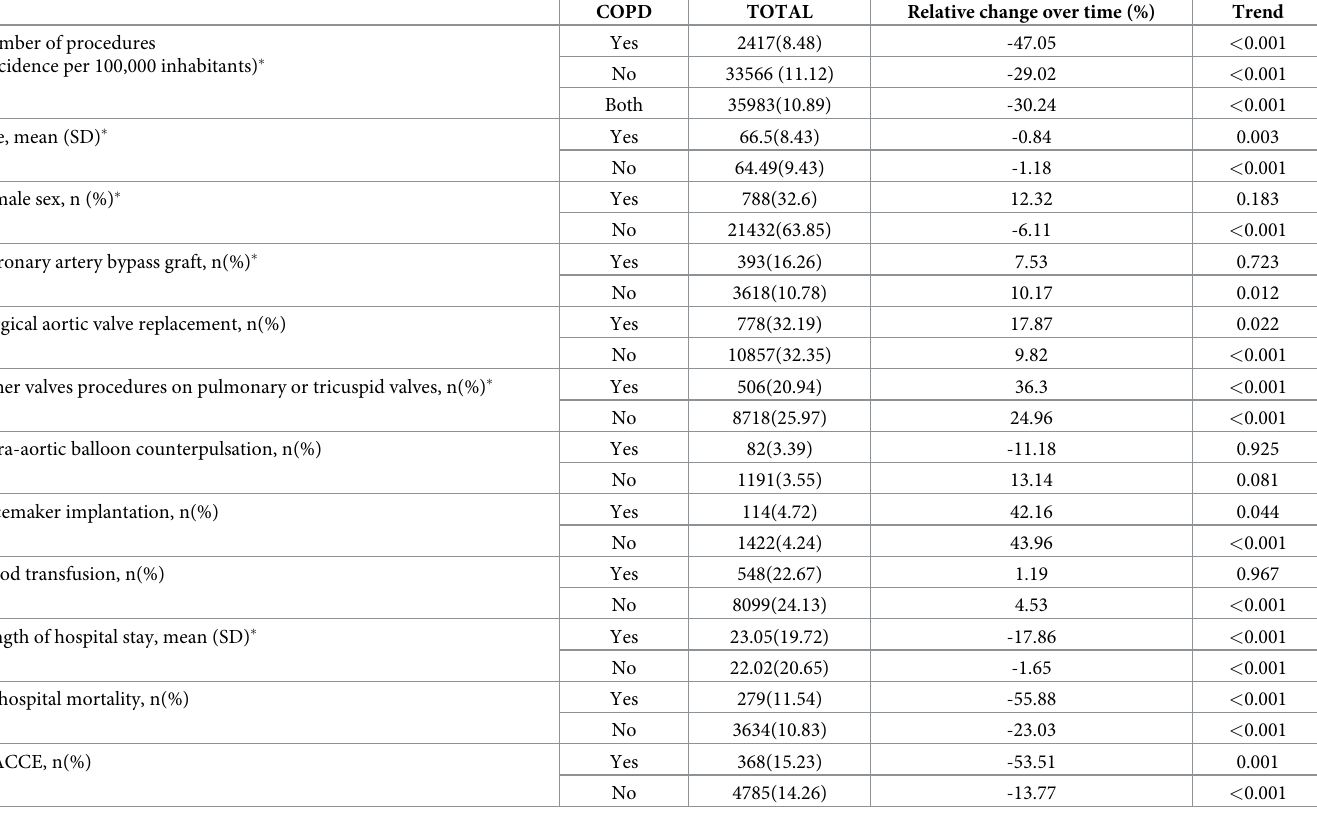
Table 2. Incidence, sociodemographic and clinical characteristics of patients hospitalized that underwent a mechanical mitral valve replacement in Spain from 2001 to 2015 according to COPD